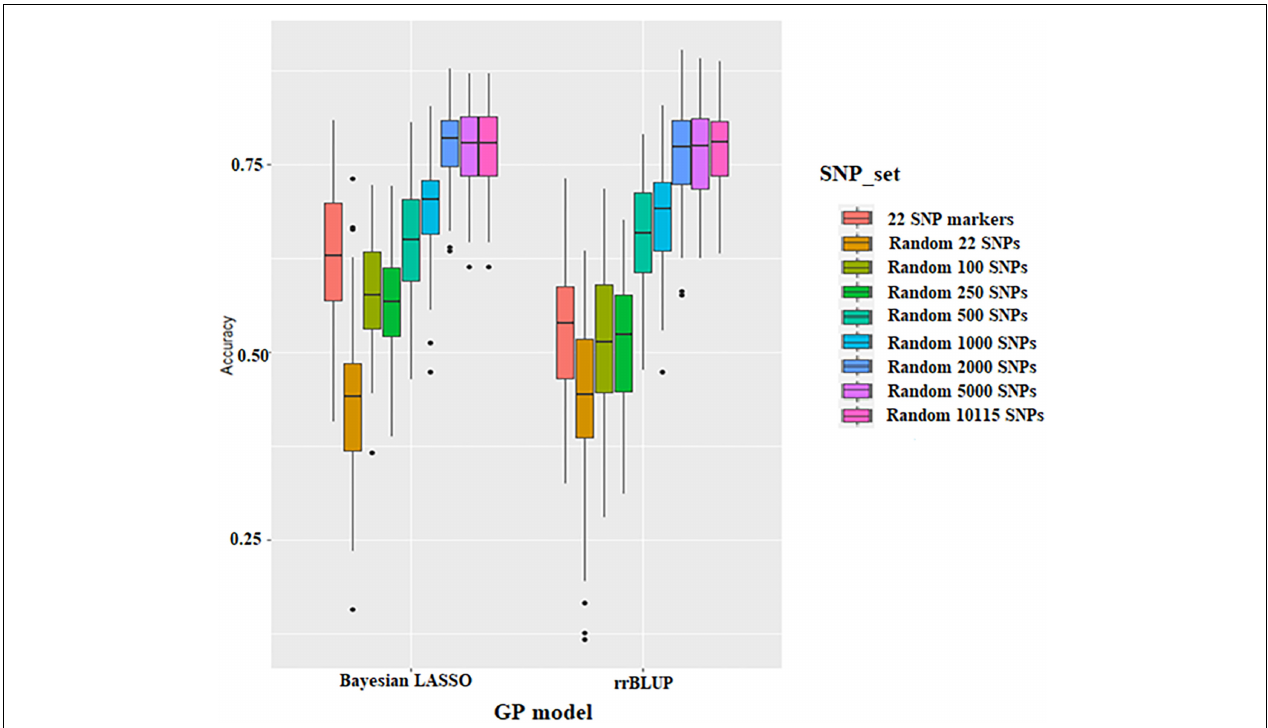
FIGURE 4 | Boxplots show the effect of different SNP density sets on genomic selection in the Bayesian Lasso Regression (BLR) model and ridge regression best linear unbiased prediction (rrBLUP)